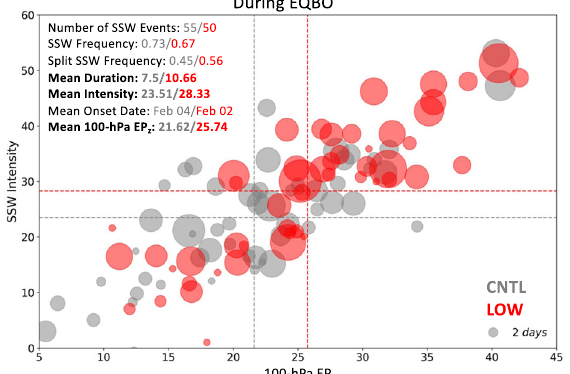
Fig. 1 Changes in SSW characteristics induced by Paci fi c-sector Arctic sea ice loss. Scatter plot of the 100-hPa EP z (vertical EP Flux component) averaged between 45°N – 75°N, 5 days prior to the onset (x-axis unit in 10 − 2 m 2 s − 2 ) versus SSW intensity (measured as a zonal-mean zonal wind deceleration, y-axis unit in m s − 1 ). Bubble size indicates the SSW duration in days, with a reference size provided. The mean values along each axis are shown as dashed lines. The split SSW frequency is the ratio of split SSW events to the total number of SSW events. Bold text indicates statistical signi fi cance at the 95%